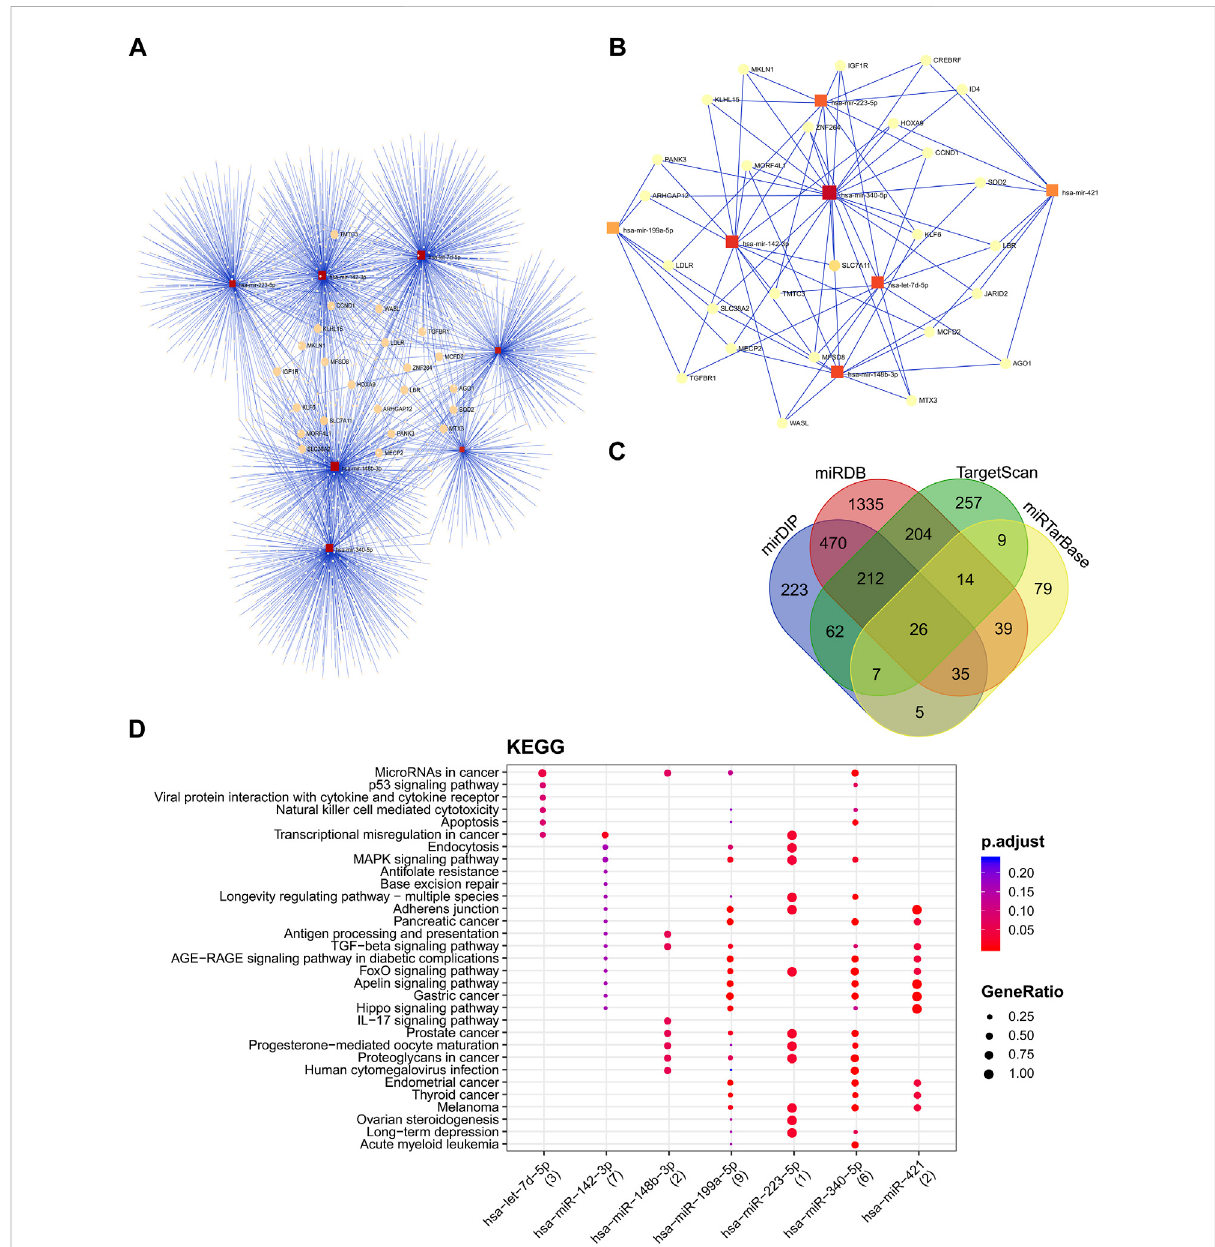
FIGURE 6 The miRNA-protein interaction network and cluster analysis of target genes and the interactions between selected miRNAs and target genes. (A) miRNA-mRNAinteractionnetworkofallsevencandidatemiRNAs. (B) ThebestmiRNAcandidateassociationwithtargetgenessquaresrepresentedmiRNAs, and circles represented target genes. (C) miRNA target prediction tools were explored and found 26 best- fi tted target genes common in all platforms. (D) KEGG enrichment analysis of DEMs. KEGG pathway analysis showed candidate miRNAs signi fi cantly implicated with the cancer-related